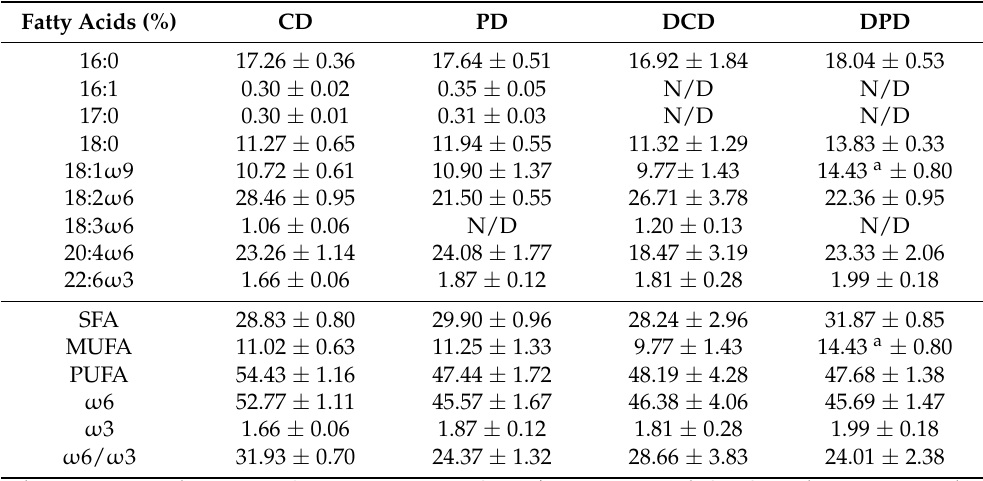
Table 1. Plasma fatty acid profile in the four groups of animals at the end of the four-week dietary intervention.